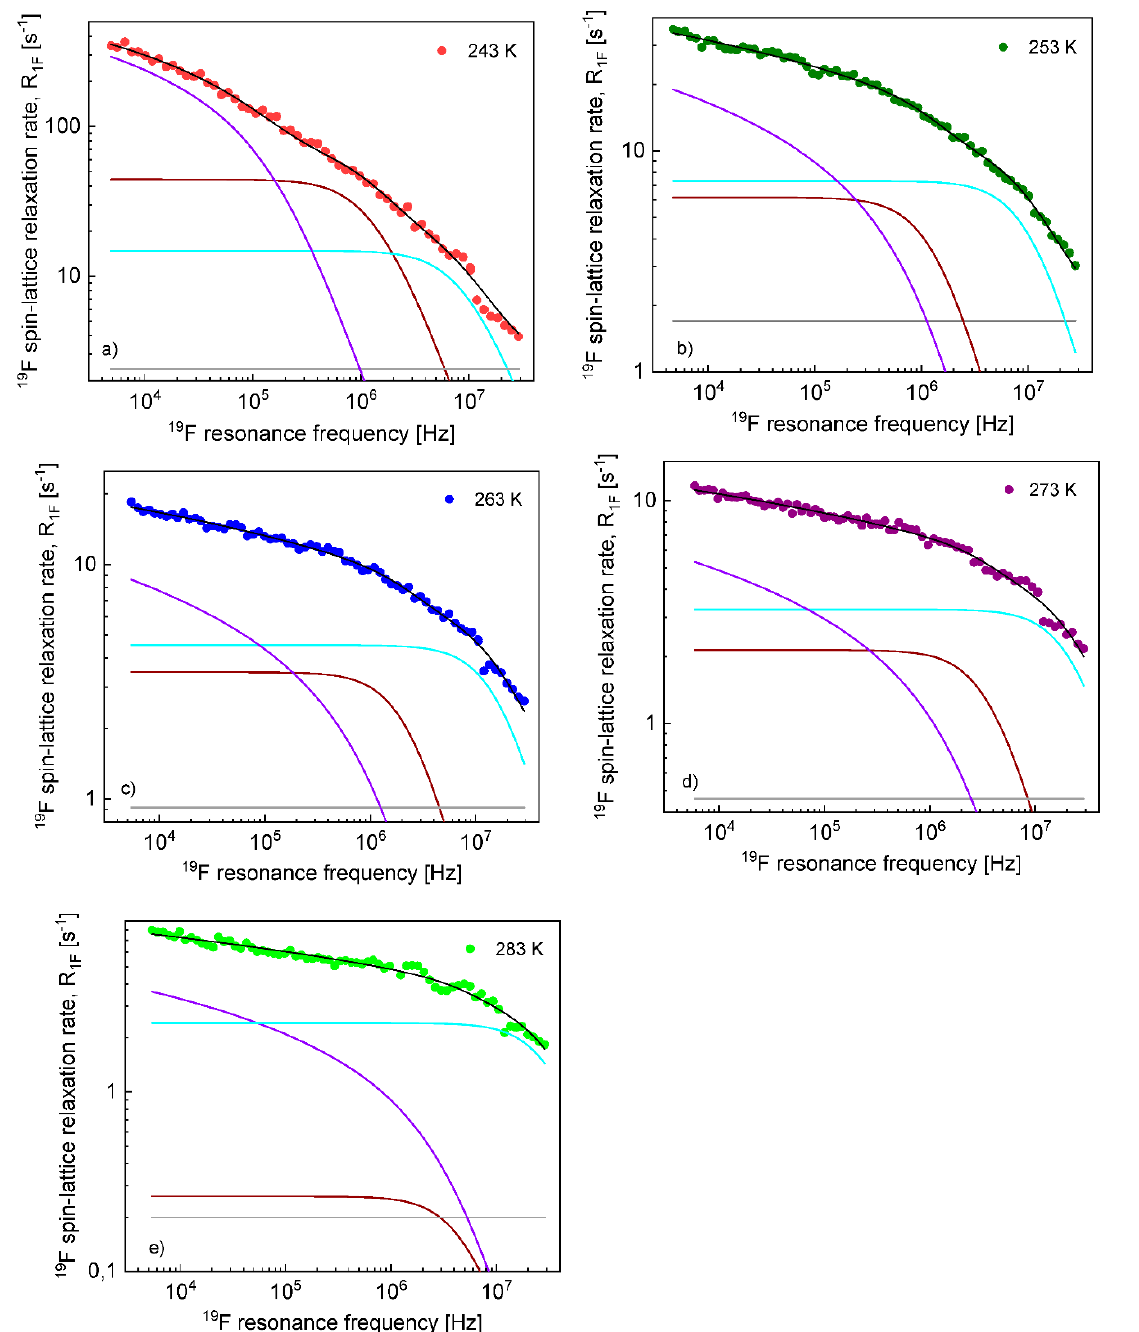
Figure 8. 19 F spin–lattice relaxation data for EMIM-FSI in the confinement ( a ) 243 K, ( b ) 253 K, ( c ) 263 K, ( d ) 273 K and ( e ) 283 K: 𝑅 1𝐹𝑐𝑜𝑛𝑓 —black line ; 𝑅 1𝐹𝑡𝑟𝑎𝑛𝑠,𝑐𝑜𝑛𝑓 —violet line; 𝑅 1𝐹𝑟𝑜𝑡,𝑐𝑜𝑛𝑓,𝑠 —brown line; 𝑅 1𝐹𝑟𝑜𝑡,𝑐𝑜𝑛𝑓,𝑓 —light blue line; and 𝐴 𝐹 —grey line.